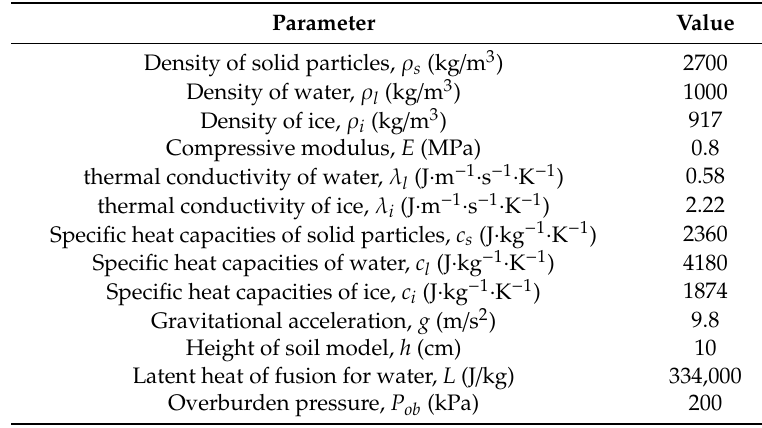
Table 2. List of parameters used in the calculation examples.